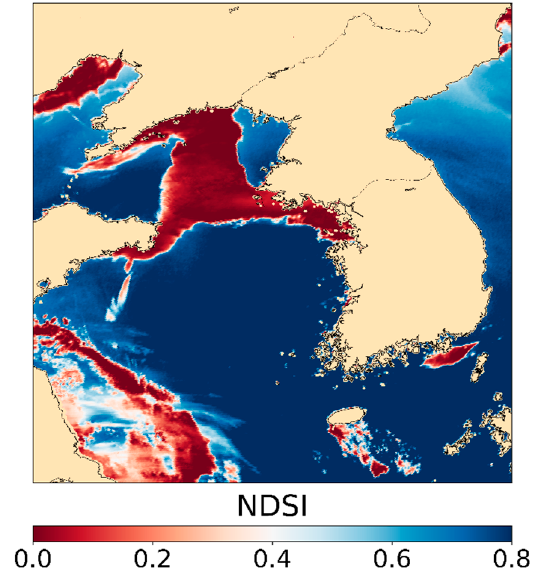
Figure 2. Example of NDSI obs on 14 March 2018, 00:30 UTC (09:30 Korean Standard Time (KST)).